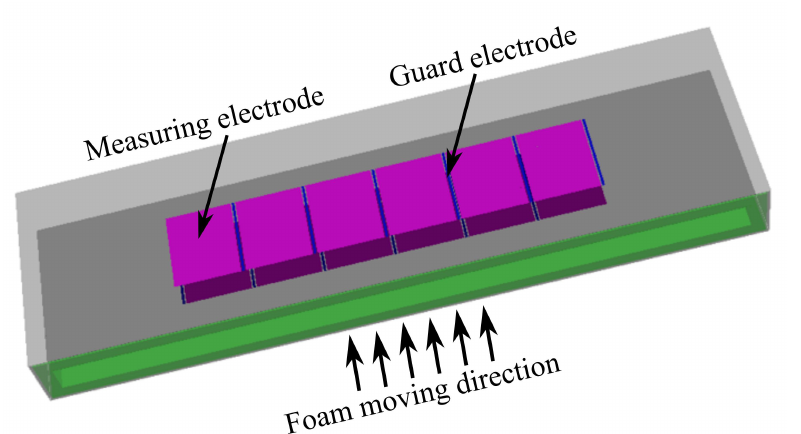
Figure 2. The ECT sensor design: six measuring electrodes and six grounded guard electrodes on the top surface and the same number of electrodes on the bottom